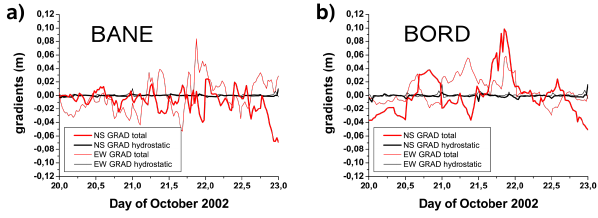
Fig. 16. Total and hydrostatic horizontal gradients (NS and EW Figure 16: Total and hydrostatic horizontal gradients (NS and EW components), for station a) BANE and 6 b) BORD over the period from 20 to 22 October (doy 293-295). 7 components), for station (a) BANE and (b) BORD over the period from 20 to 22 October (doy